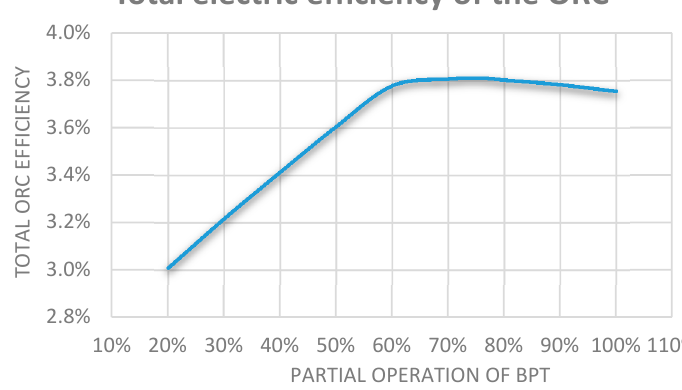
Figure 15. Sensitivity analysis of the ORC electric efficiency at the partial operation.